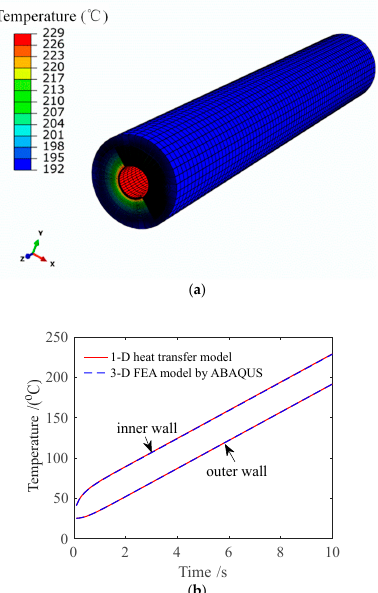
Figure 4. Validation of the 1D numerical heat transfer model: ( a ) 3D FEA model established by ABAQUS; ( b ) comparison of calculated temperature on the inner and outer walls.